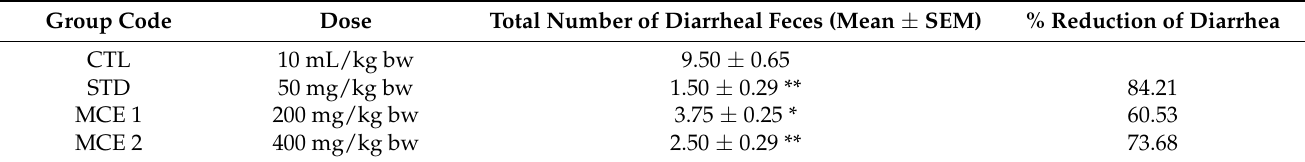
Table 4. The antidiarrheal activity of the methanolic crude extract of the W. tinctoria stem. Group Code Dose